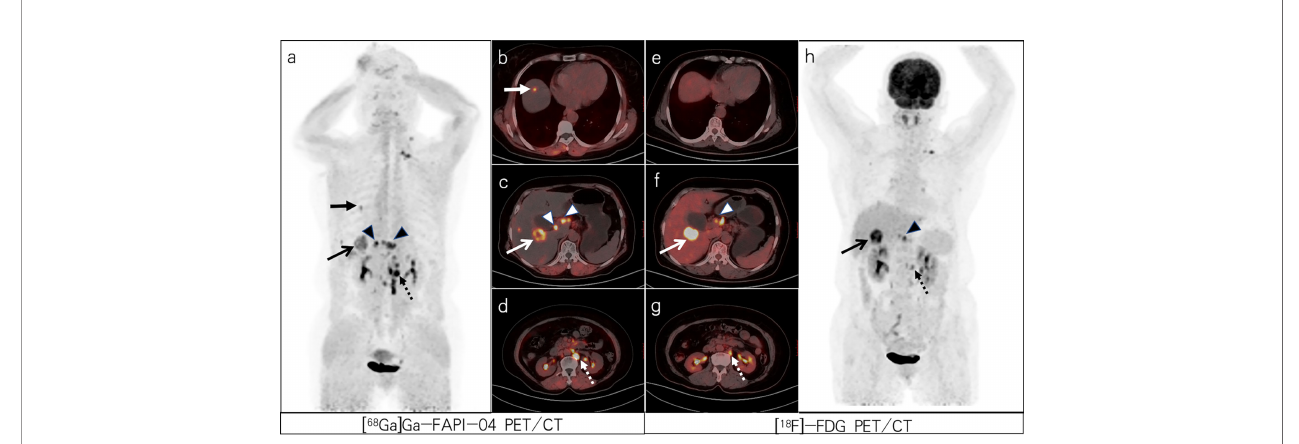
FIGURE 1 | A 64-year-old woman with poorly differentiated gastric adenocarcinoma based on pathological biopsy under gastroscopy. Both [ 68 Ga]Ga-FAPI-04 (A, C) and [ 18 F]-FDG PET/CT (F, H) were negative in the primary focus. Compared with [ 18 F]-FDG PET/CT (E – G) , [ 68 Ga]Ga-FAPI-04 PET/CT (B – D) resulted in a higher liver/background ratio and identi fi ed more liver lesions (slender arrows, SUVmax=6.3 vs. 11.3) and para-aortic lymph node metastases (dashed arrows, SUVmax=12.8 vs.